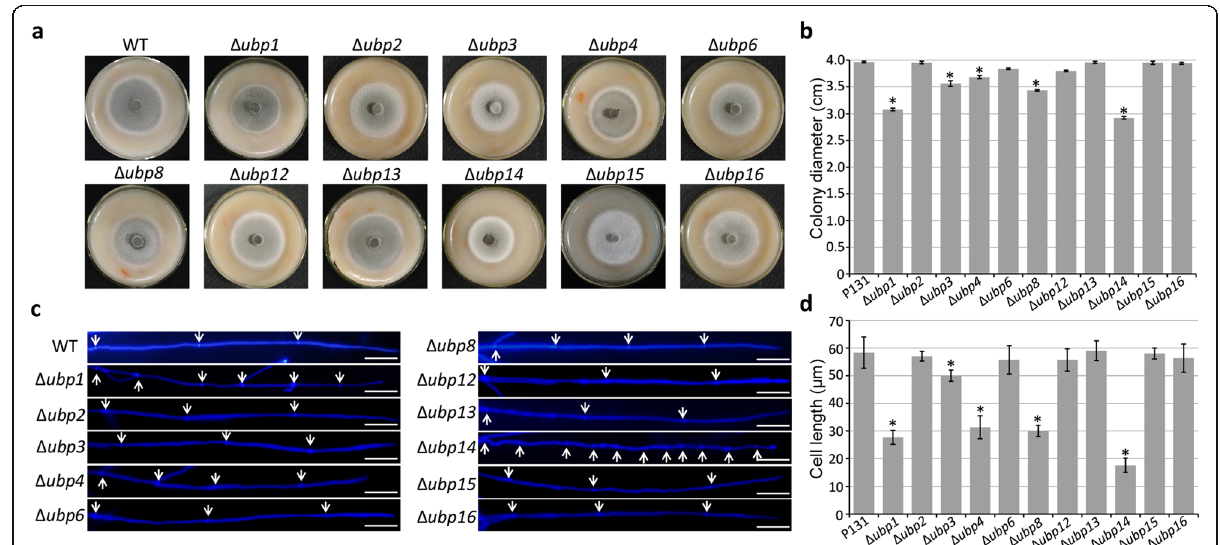
Fig. 4 Vegetative growth of the ubp mutants. a The wild-type strain and the ubp mutants were inoculated on OTA plate and cultured at 28 °C for 5 days and then photographed. b Colony diameter. Significant differences compared with the wild type are indicated by asterisks ( P < 0.05). c Calcofluor White staining of hyphal tips shows the distance of septa. White arrows indicate the cell septa. Bar, 20 μ m. d Average cell length of the hyphal tips. Significant differences compared with the wild type are indicated by asterisks ( P <